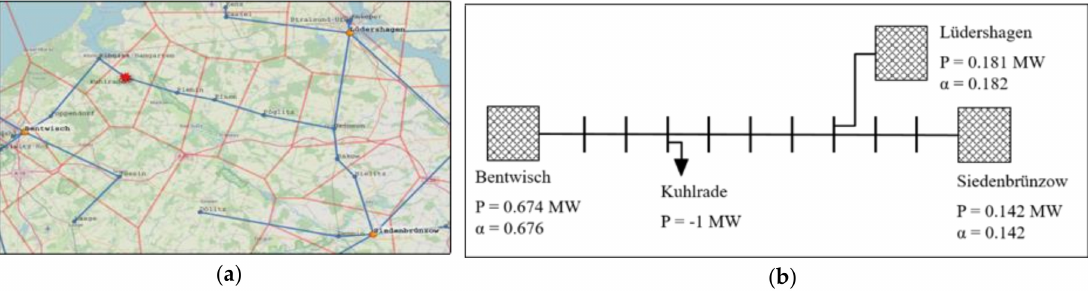
Figure 2. ( a ) Distribution grid and catchment areas; ( b ) sub-network and power-flow-based